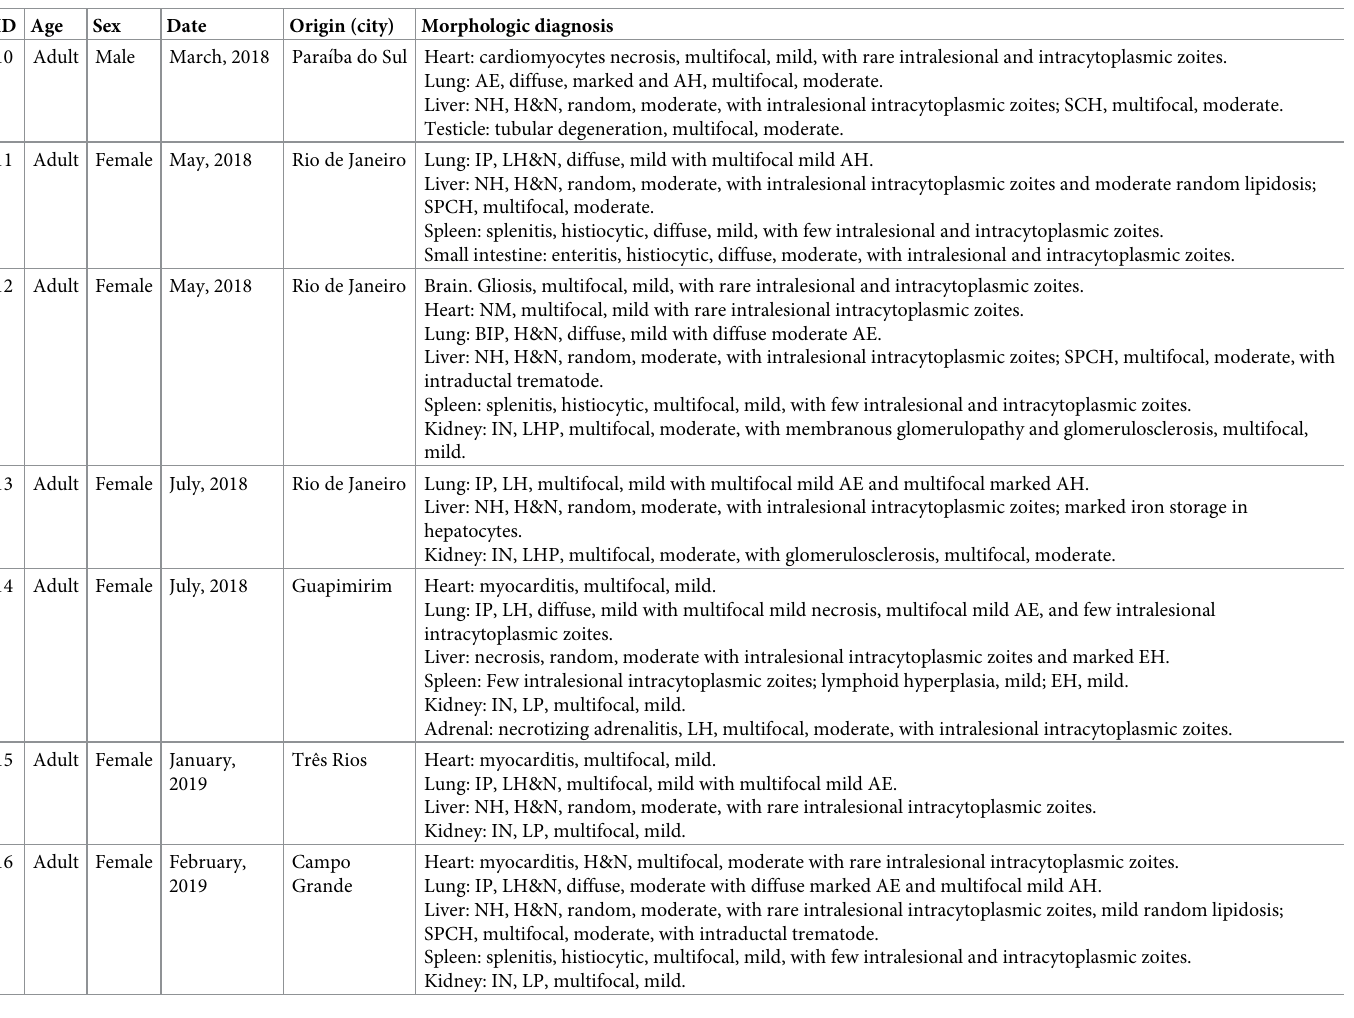
identified in the cytoplasm of hepatocytes in areas without inflammation or necrosis, and tachyzoites were observed in Kupffer cells, hepatocytes, and free in the necrotic areas (Fig 3B). Iron storage in hepatocytes, evidenced by Prussian blue stain, was observed in 18.8% (3/16; CI: 6.6–43.0%) of the cases, but was not necessarily associated with the T . gondii infection (Fisher’s exact test, p = 0.0728). Extramedullary hematopoiesis (12.5%; 2/16. CI: 2.2–36.0%), sinusoidal leukocytosis (18.8%; 3/16; CI: 6.6–43.0%) and syncytial hepatocytes (18.8%; 3/16; CI: 6.6– 43.0%) were also observed in these cases but were considered non-specific findings (Fisher’s exact test, p = 0.37, p > 0.9999 and p = 0.7299, respectively). Importantly, there was a signifi- cantly higher frequency of cholangiohepatitis with intraductal trematodes, compatible with Platynosomum spp., in toxoplasmosis cases (25.0%; 4/16) compared to the frequency of Platy- nosomum spp. in non-infected animals (8.6%; 5/985; Fisher’s exact test, p =